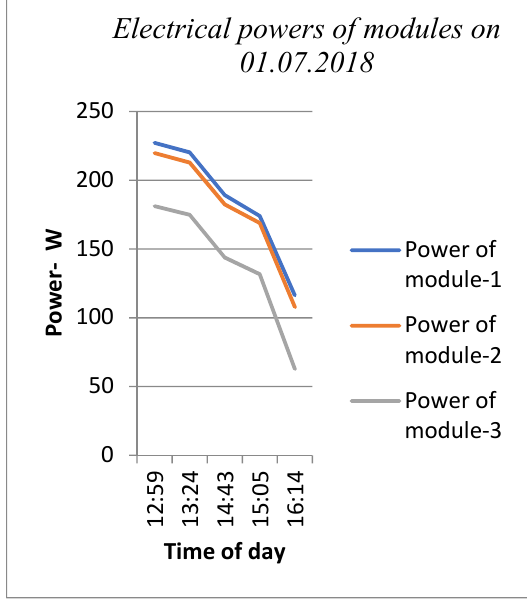
Figure 9. Electrical powers of moduleson 01.07.2018.